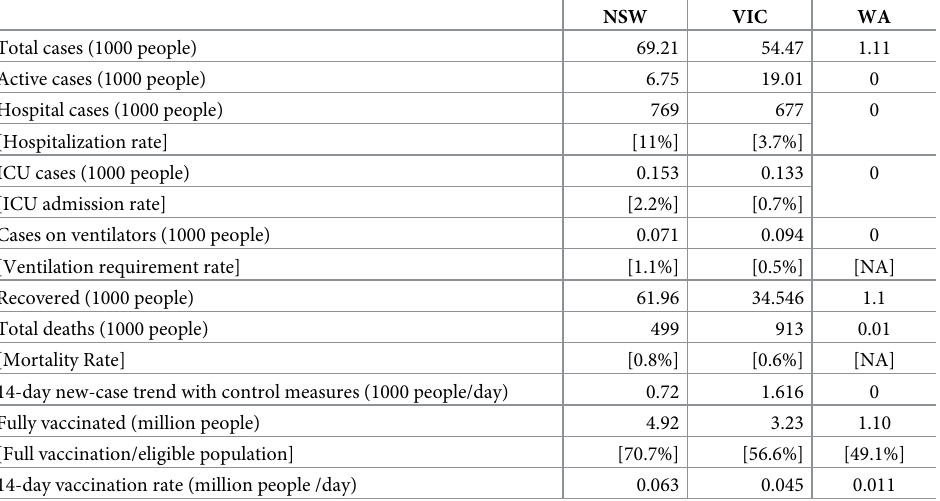
Table 2. Summary of key COVID-19 Statistics in NSW, VIC, and WA, as of October 11 th 2021.